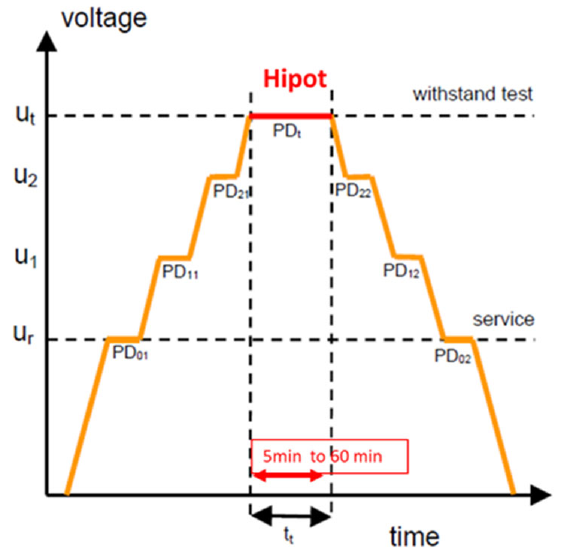
Figure 4. A voltage withstand test sequence with PD measurement in parallel: Ur = U 0, U 1 = 1.25 U 0 ; U 2 = 1.5 U 0 , U t = 1.7 U 0 [8].